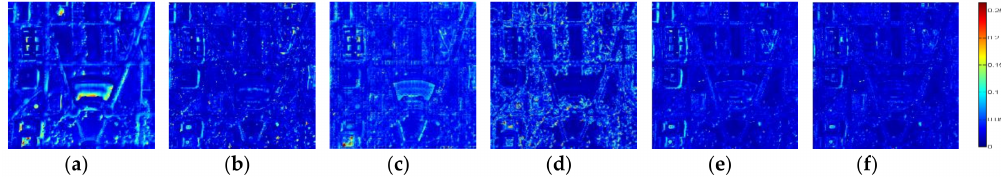
Figure 5. SAM maps of the enhanced images for Washington D.C. dataset: ( a ) MAP; ( b ) CNMF;